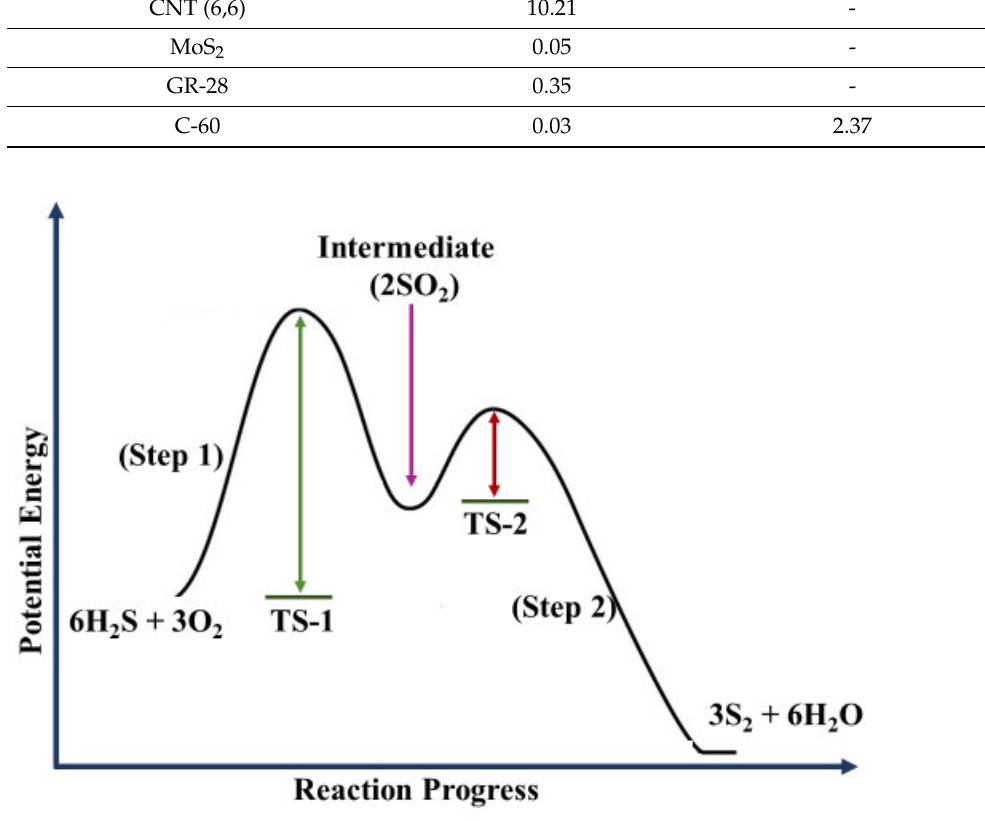
Figure 1. Conceptual rendition of the theoretical two-step transition state reaction path for the dehydro- sulfurization reaction. The black curve indicates net chemical results from Equations (1) and (2) where the activation energies (TS-1) and (TS-2) are the 2-transition state (TS) barriers calculated by ∆ TS = TS-initial state for barrier height values for each step represented by the green and dark red arrows respectively. The purple arrow represents the intermediate formation of 2 molar sulfur dioxide.